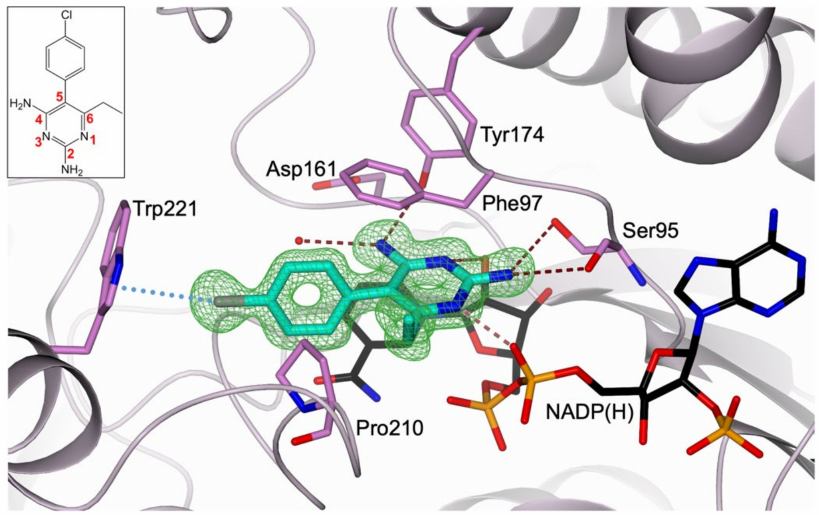
Figure 3. Active-site view of Tb PTR1 (lilac cartoon; residues in sticks, orchid carbon atoms) in complex with NADP(H) (in sticks, black carbon atoms) and PYR (in sticks, cyan carbon atoms). PYR is surrounded by the omit map (green mesh) contoured at the 3.0 σ level. The PYR chemical structure and its atom numbering are shown in the inset. Water molecule is displayed as a red sphere. In all figures, hydrogen and halogen bonds are represented as tan dashed lines and light-blue dotted lines, respectively. Oxygen atoms are colored red, nitrogen blue, phosphorus orange, and chlorine